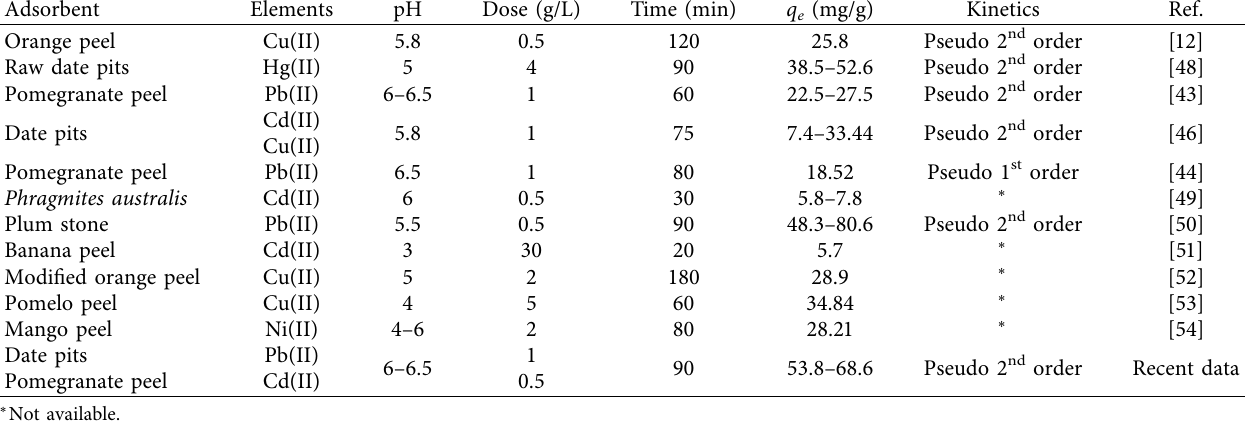
Table 3: Comparison of the parameters affecting the maximum adsorption efficiencies of different metal ions using different agricultural precursors between the two AC